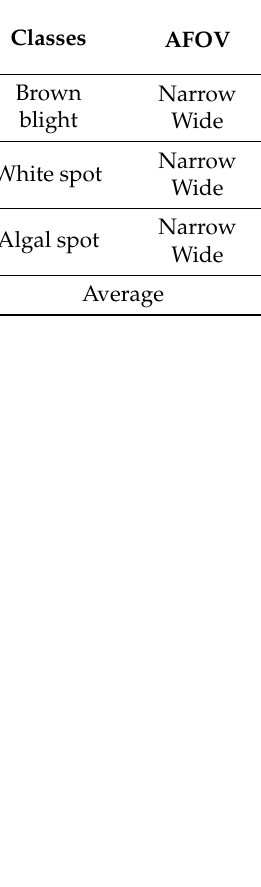
brown blight, algal spot, and white spot leaf disease,